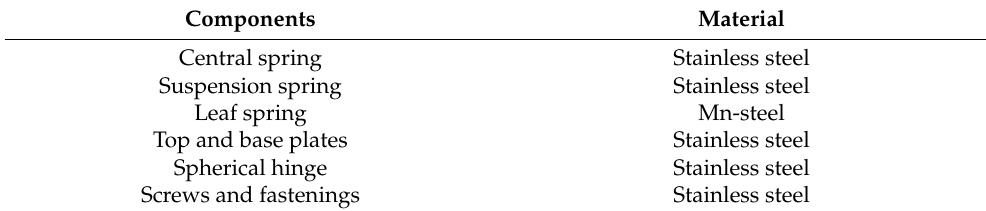
Table 2. The material parameters. Components Material